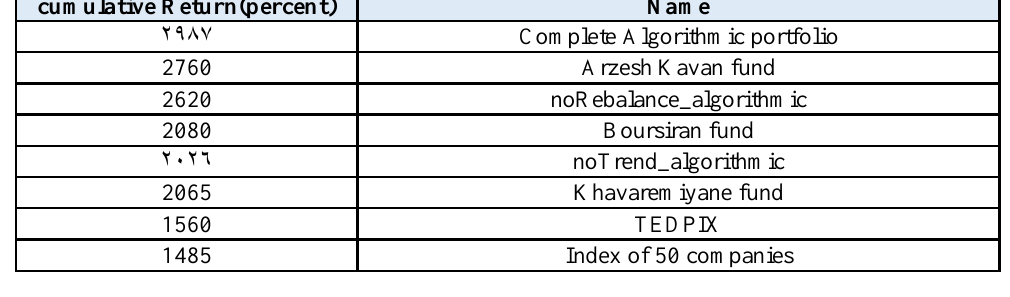
Table 6. Comparison of algorithmic portfolios with other funds in all criteria cumulative Return(percent)